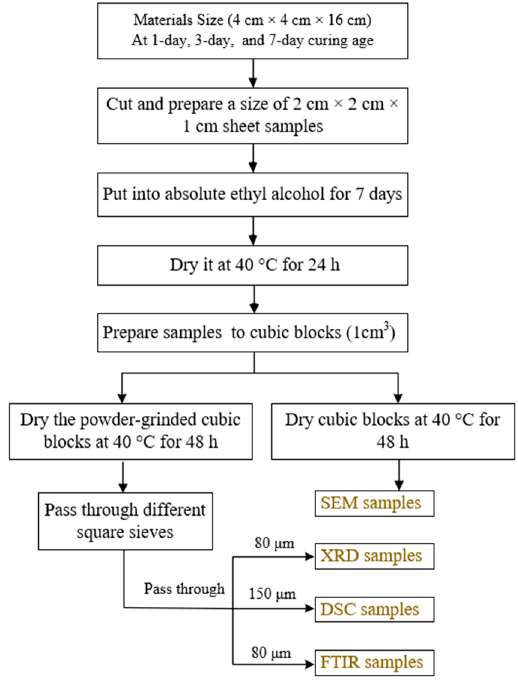
Figure 2. Sample preparation process.